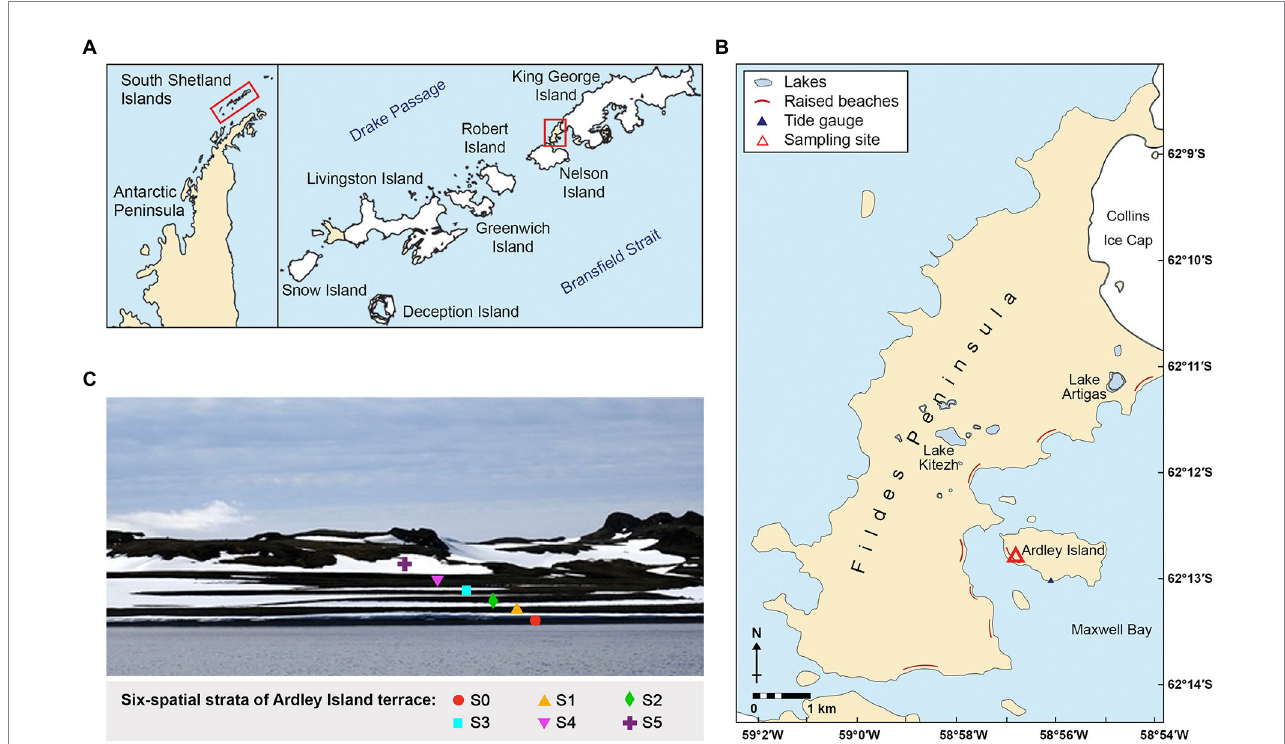
FIGURE 1 Site location; (A) Maps of the Antarctic Peninsula and the South Shetland Islands, (B) Locations of the Ardley Island terrace (marked as a red triangle), and (C) The Ardley Island terrace: stage